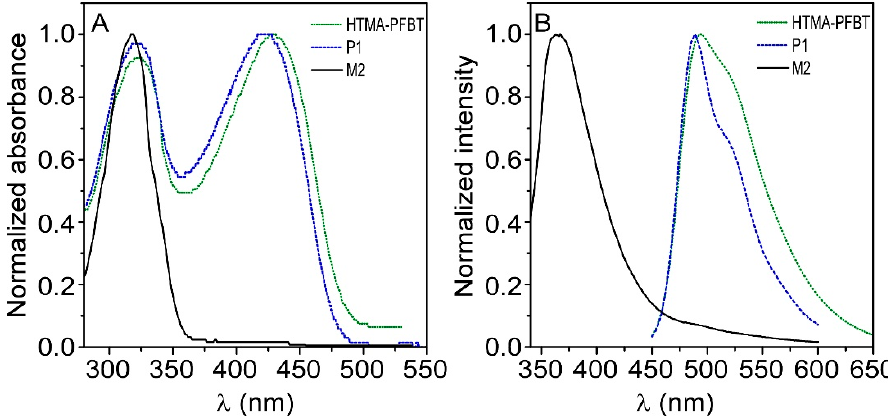
Figure 1. Normalized absorption ( A ) and fluorescence emission spectra ( B ) of M2 (black) and P1 (blue) in Tetrahydrofuran (THF) and HTMA-PFBT (green) in ethanol. Excitation wavelength ( λ exc ) was 320 nm for M2 and 425 nm for P1 and HTMA-PFBT.